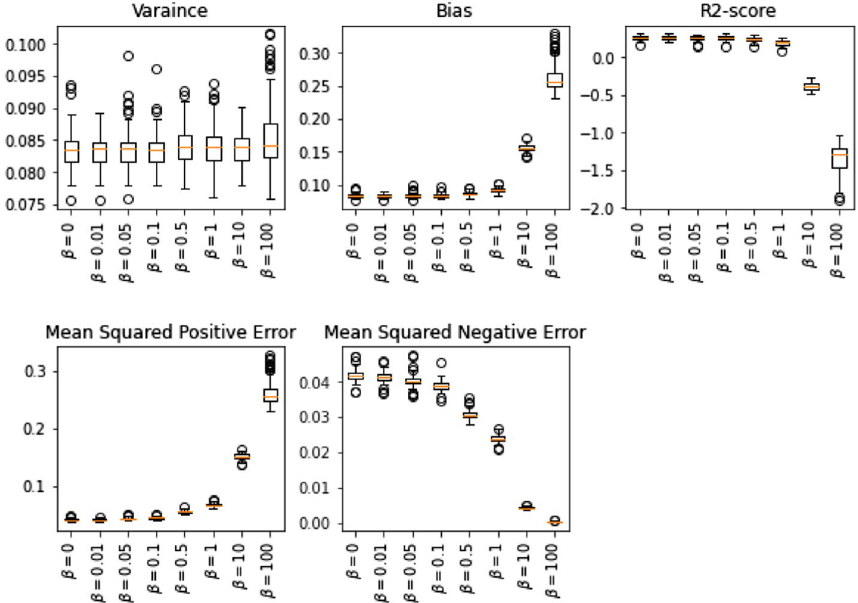
Fig. 2 The effect of hyperparameter β on variance, bias, and score of multivariate linear